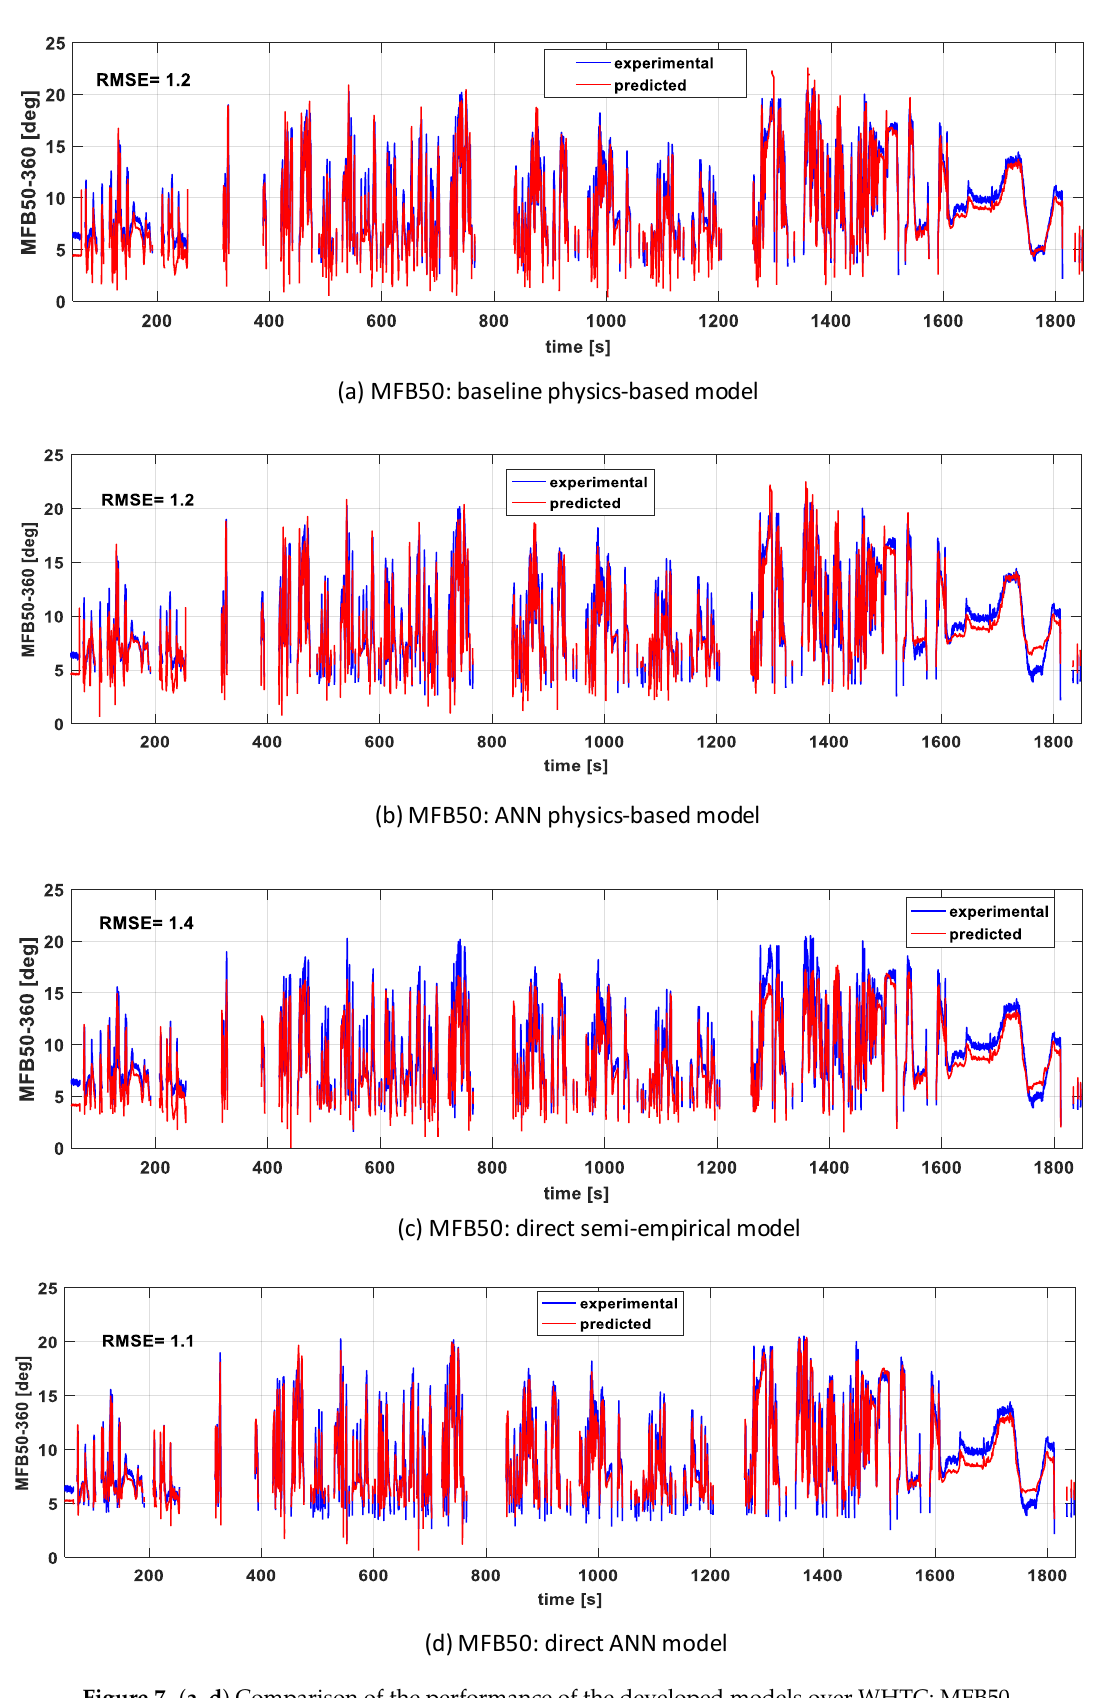
Figure 7. ( a – d ) Comparison of the performance of the developed models over WHTC: MFB50.